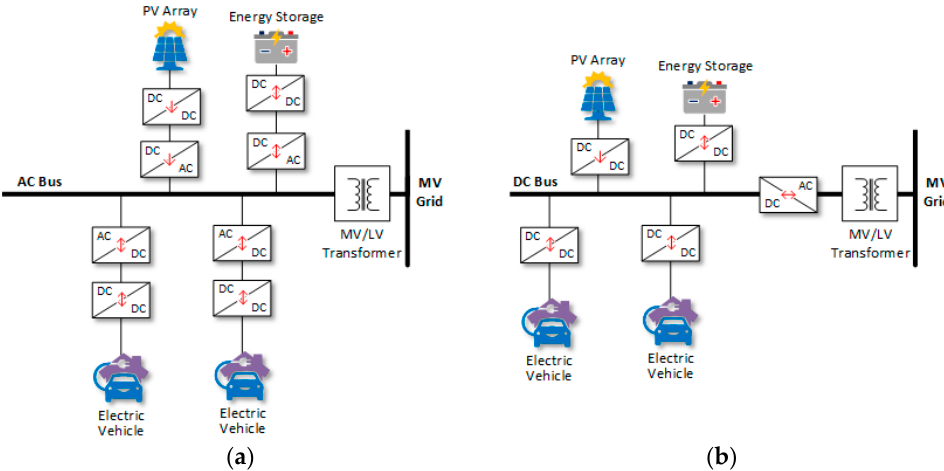
Figure 4. Fast-charging station configurations with: ( a ) AC-bus coupling; ( b ) DC-bus coupling.